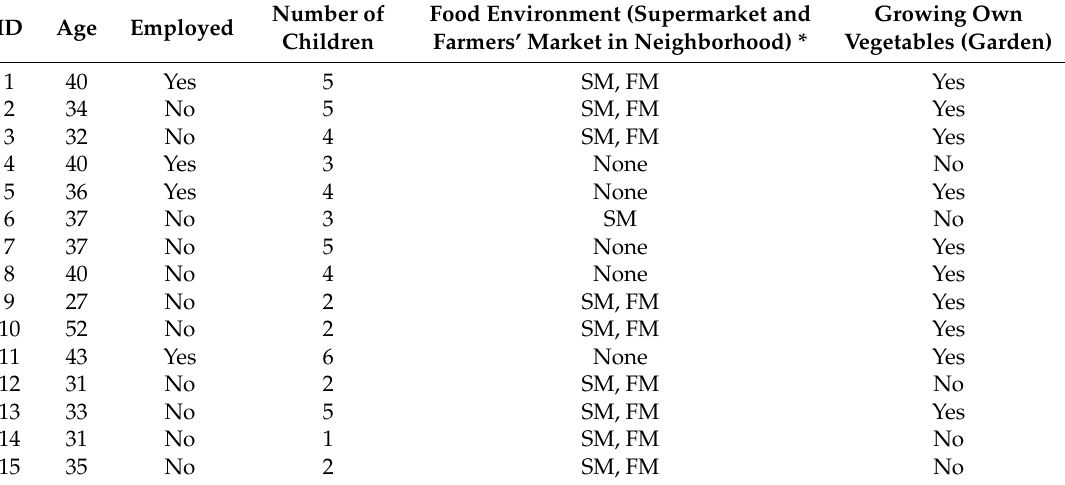
Table 5. Characteristics of participants who took part in the qualitative